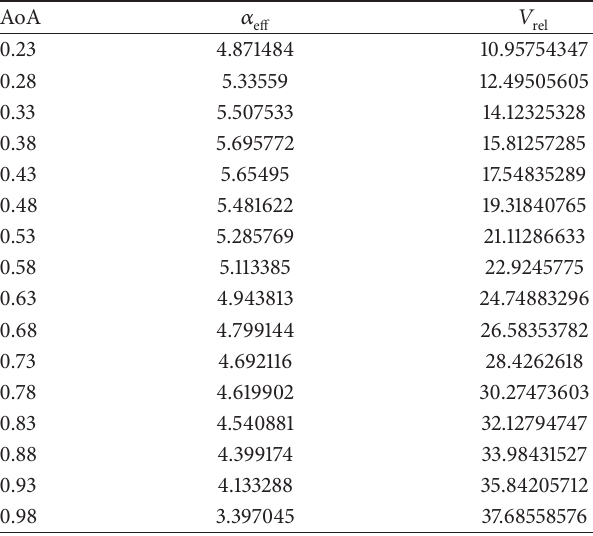
Table 4: Effective angle of attack and relative velocity for 𝑉 0 =